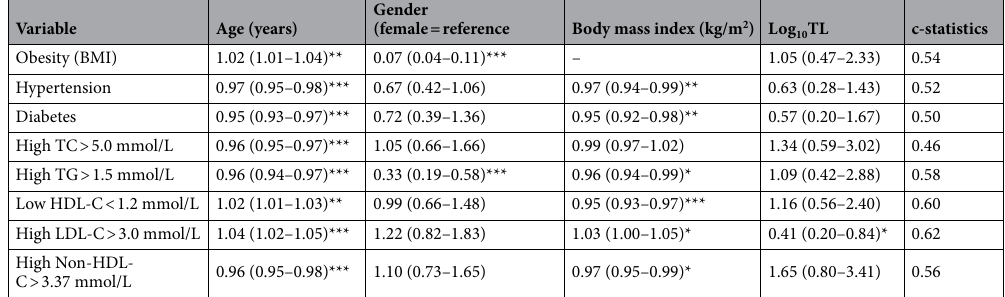
Table 5. Logistic regression models (odds ratios and 95% confidence intervals) for the associations of Log 10 telomere length with cardio-metabolic conditions. Legend: BMI body mass index, SBP systolic blood pressure, DBP diastolic blood pressure, TC total cholesterol, TG triglyceride, HDL-C high density lipoprotein cholesterol, LDL-C low density lipoprotein cholesterol, TL telomere length, *** = p < 0.001, * = p <